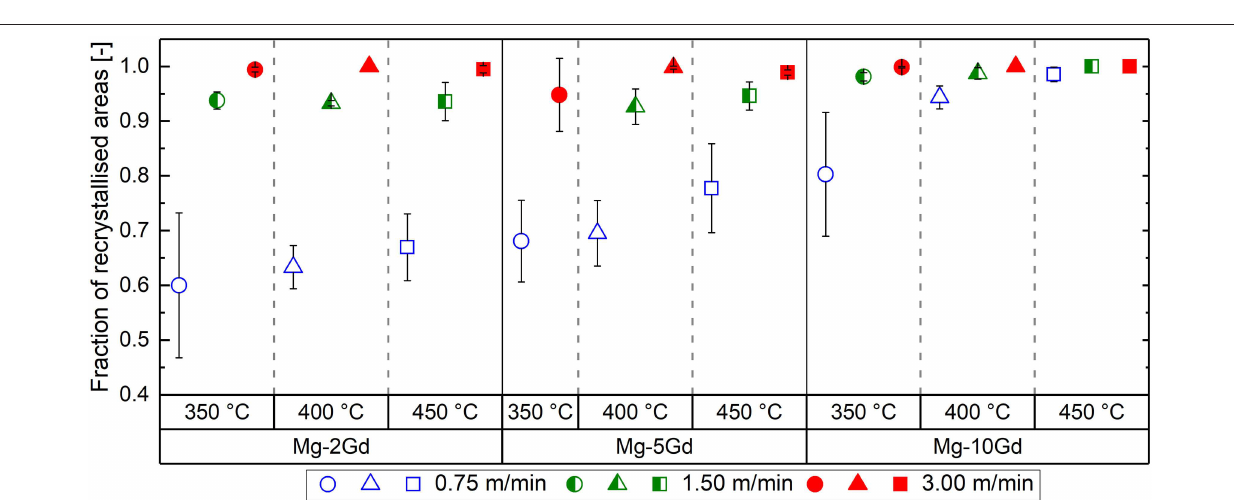
strengths decrease with increasing extrusion temperatures